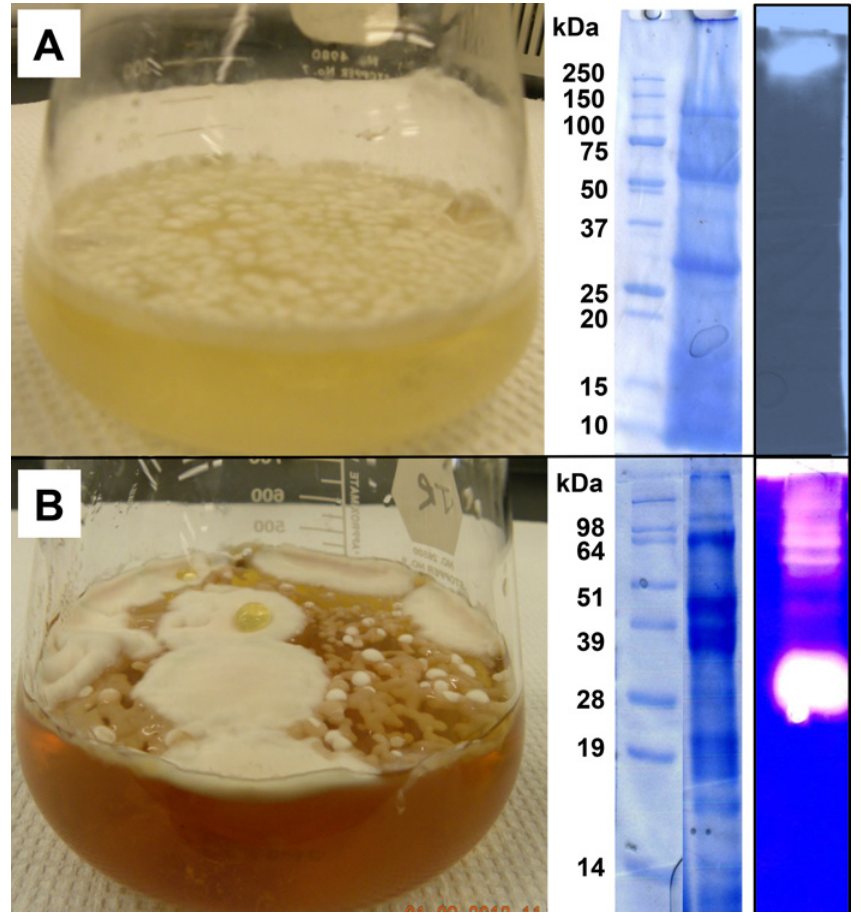
Fig 1. Pseudogymnoascus destructans growth in static liquid cultures. Left panel depicts typical culture morphology in minimal nutrient broth with gelatin (A) compared to a nutritionally complex tryptic soy broth (B). The right panel depicts a SDS-PAGE (Coomassie-Brilliant Blue G-250 stain) of extracellular proteins recovered from culture media and a native gel zymogram (casein) illustrates protease activity from total protein